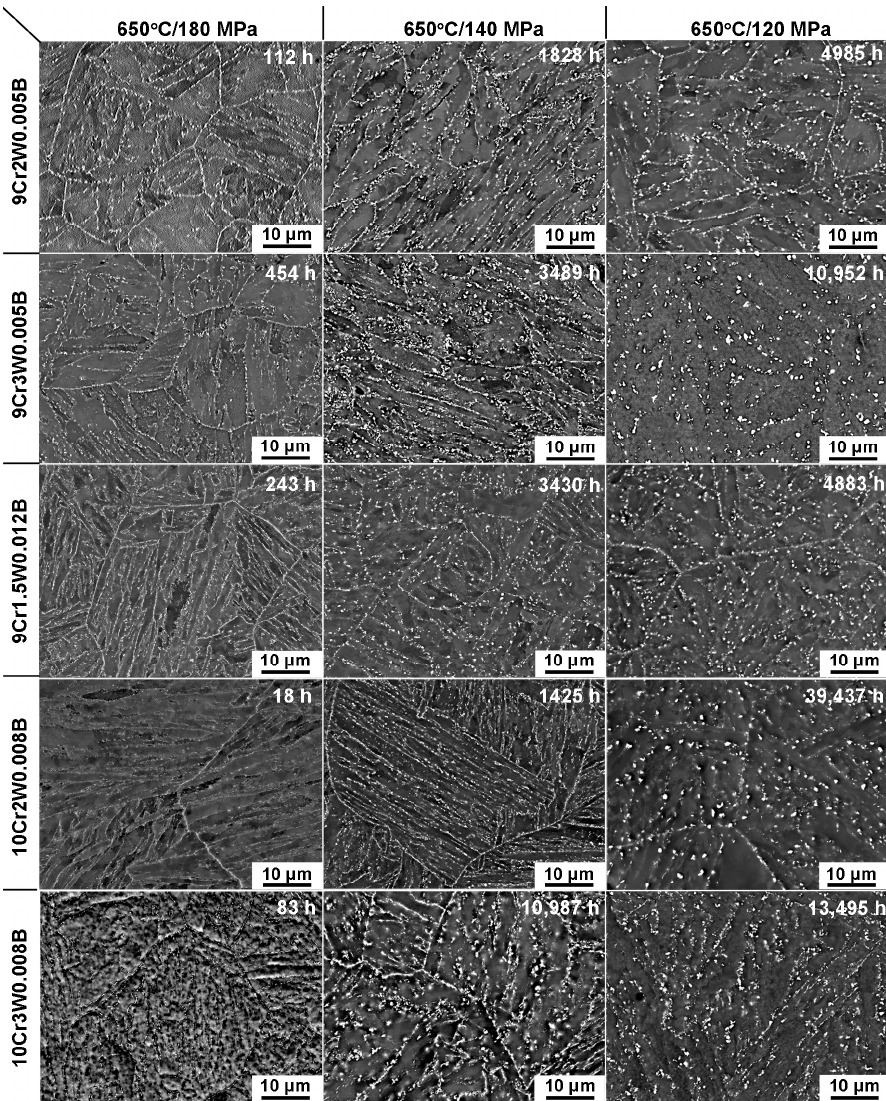
Figure 4. SEM-back scattered electron (BSE) images of all steels studied after some creep rupture tests corresponding to the regions of short-term creep (180 MPa), transition creep (140 MPa) and long-term creep (120 MPa). Numbers indicate the rupture time for each creep test. The white and grey particles correspond to Laves phase and M 23 C 6 carbides, respec- tively.